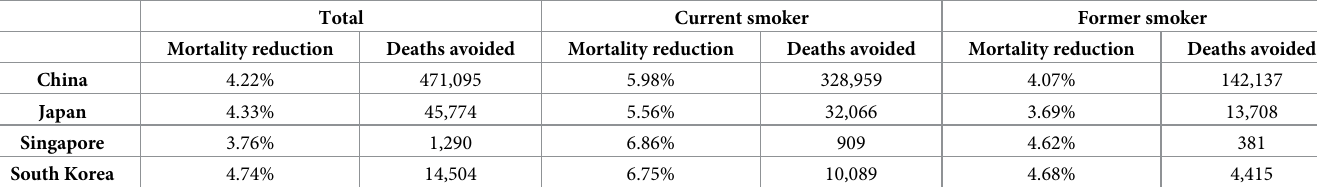
Table 3. Projected lung cancer morality reduction and deaths avoided by smoker type, 2020–2040.